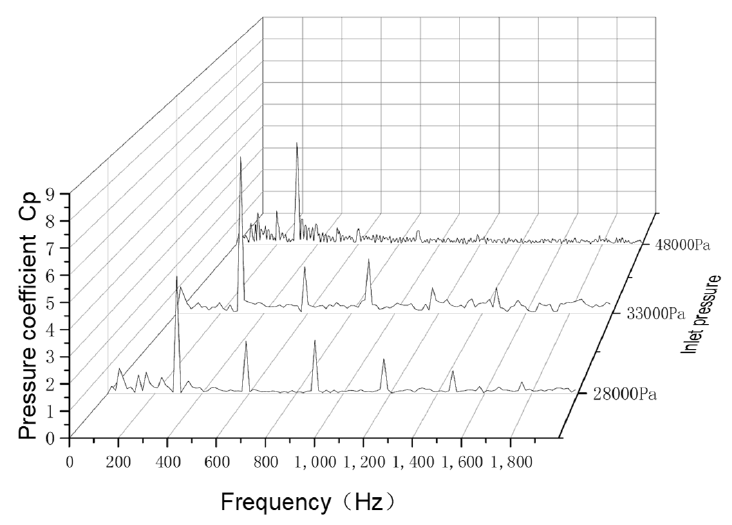
Figure 15. Frequency-domain diagram of pressure pulsation at the volute outlet.